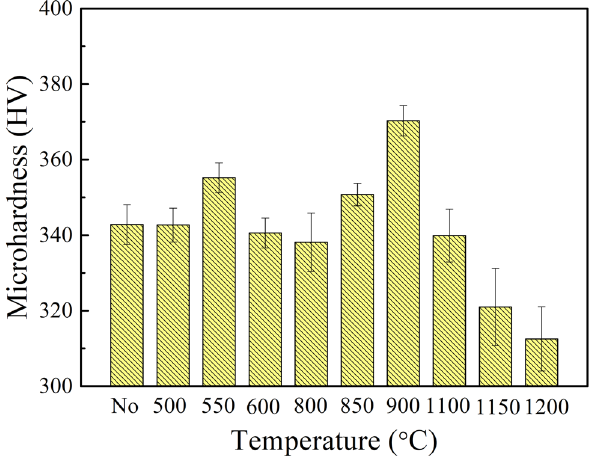
Figure 12: Hardness values of the as - sintered and as - annealed